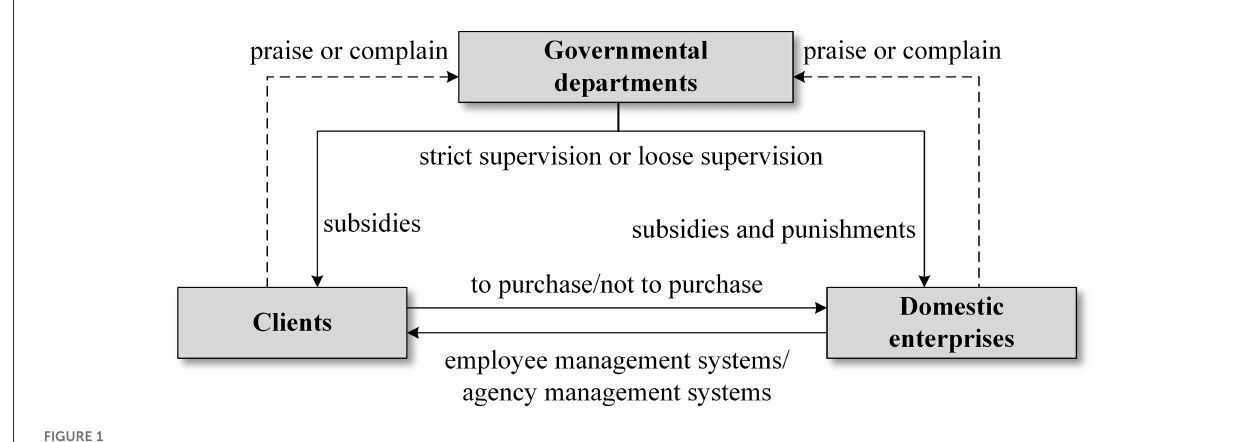
FIGURE1 Schematic diagram of structural